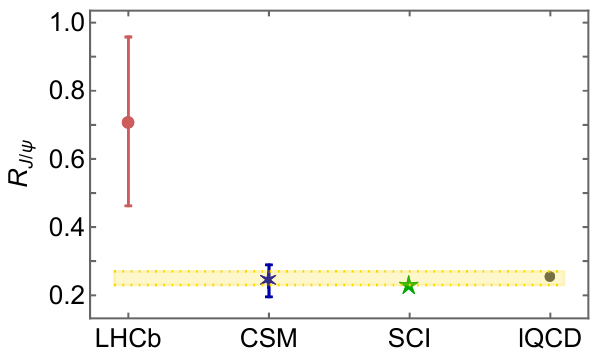
Figure 19. Ratio R J / ψ in Equation (51)—red circle, empirical result [371] (LHCb); blue asterisk— CSM prediction [206]; green star—SCI prediction [366]; grey circle—lQCD result [378,379]; gold band—unweighted mean of central values from several calculations